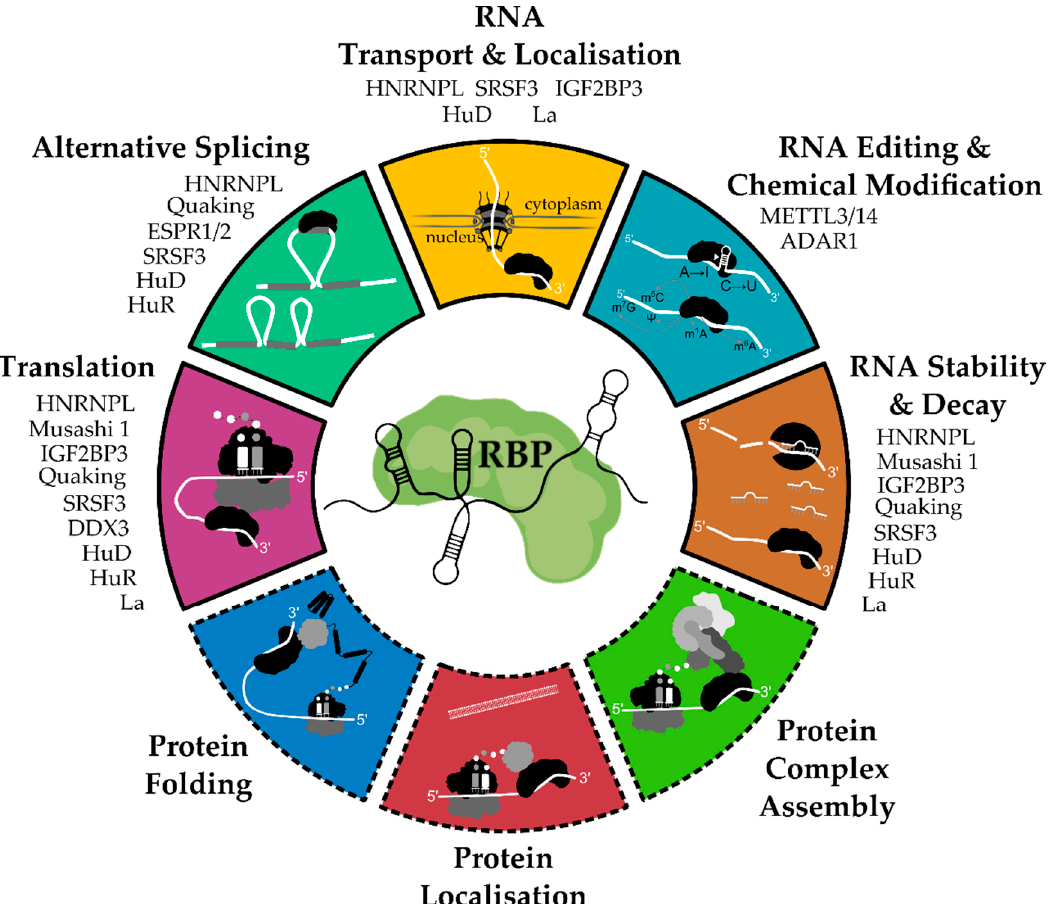
Figure 1. Functional hallmarks of RNA-binding proteins (RBPs). RBPs are important post-transcriptional regulators of gene expression. They are well-known to regulate RNA translation, splicing, transport, editing and chemical modification as well as turnover. Moreover, emerging functions of RBPs in co-translational protein complex assembly, protein localization and protein folding have been recently suggested. Hence, deregulated RBP activities can have broad effects on cellular homeostasis and are associated with several human diseases. Oral cancer-associated RBPs highlighted in this article have been assigned to relevant hallmark functionalities based on their established roles in human cancers as well as developmental processes.